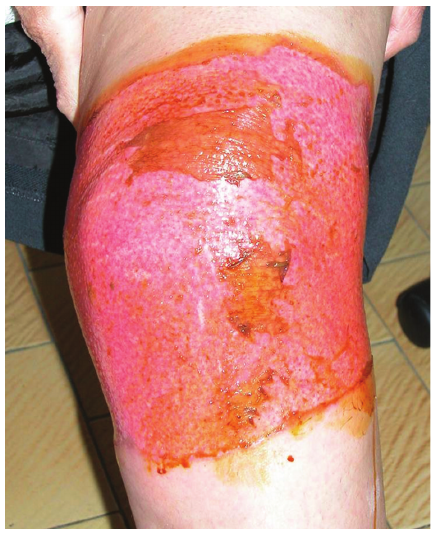
Figure 1: Second-degree skin burn due to mustard seed usage.